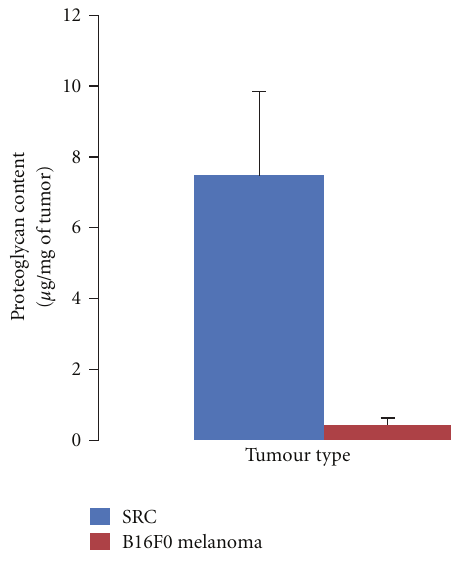
Figure 5: PG content of SRC tissue, respectively, to murine melanoma tumour (as negative control); Mean values + standard deviation are